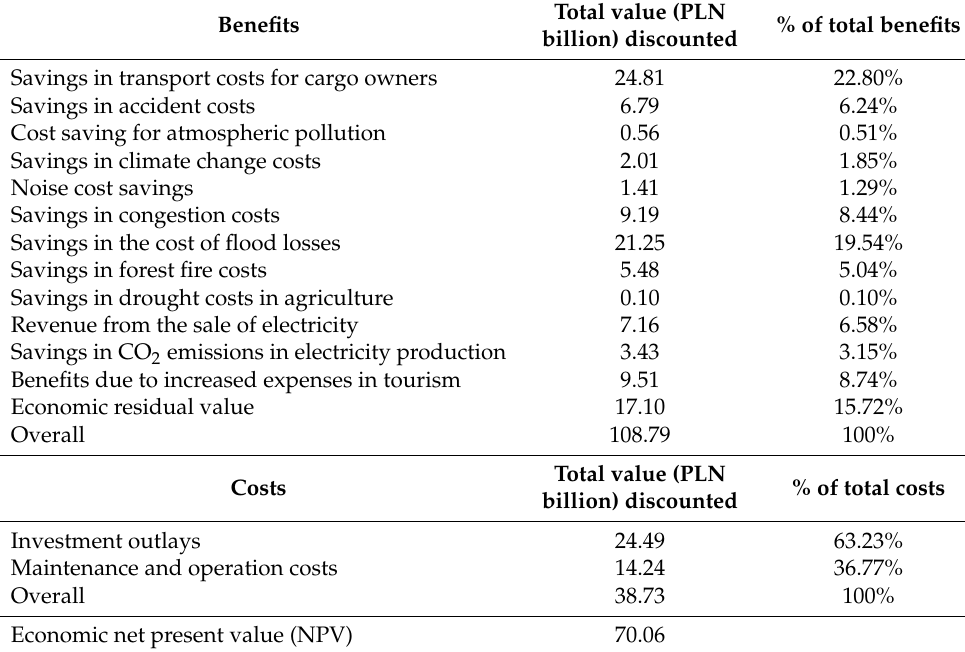
Table 3. Summary of the cost–benefit analysis